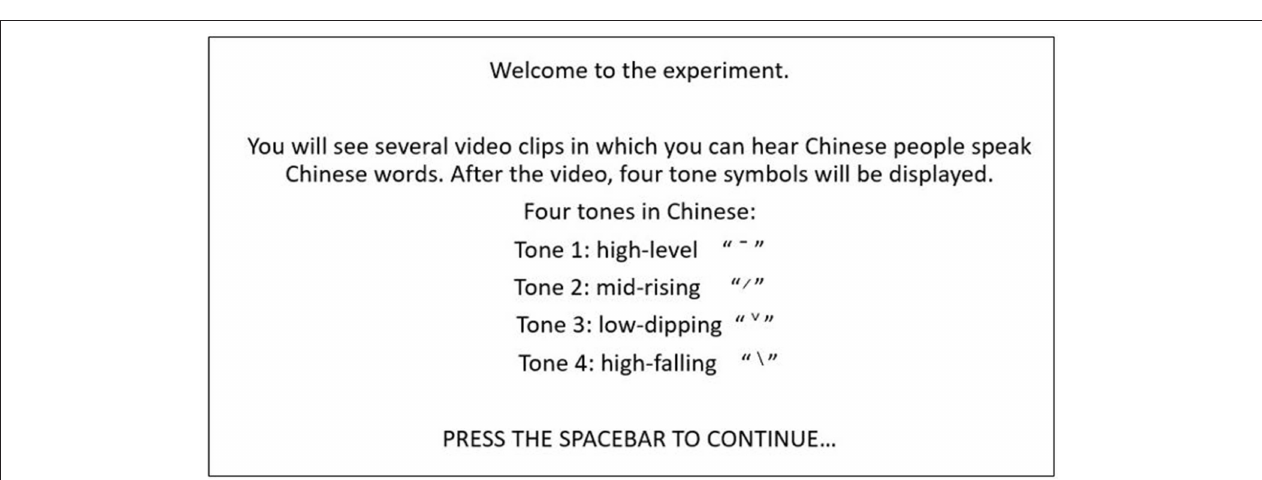
FIGURE 1 | Screenshot for a brief introduction for Mandarin Chinese tones (in auditory-visual conditions).